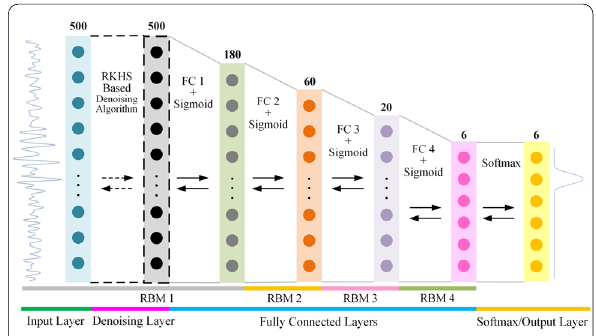
Figure 4 DBN based structure applied to the experiment